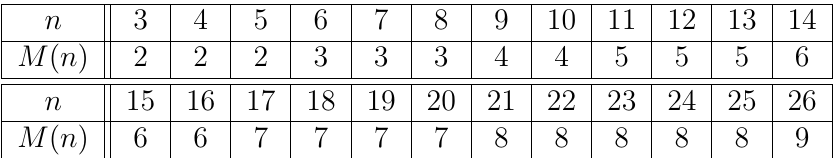
Table 7: Minimum largest term M ( n ) of forcibly connected graphical sequences of length n .